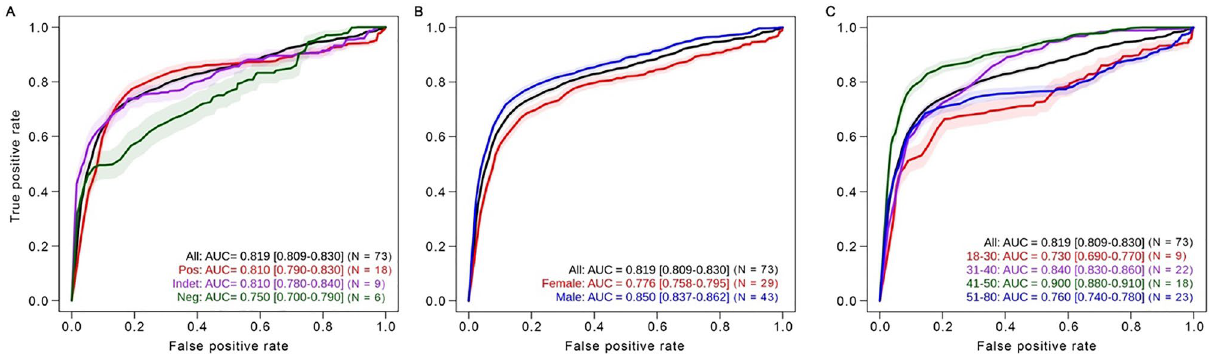
Figure 4. Accuracy changes across different populations. The model trained at PX + 0: PX + 2 showed different performance accuracy (ROC AUC) when we segregated participants by antibody test result ( A ), sex ( B ) and age group ( C ); [95% CI] (N). Each panel uses the participants ( n = 73) who reported positive diagnostic tests for SARS CoV-2 and were included in algorithm training. Pos = positive, Indet = indeterminate, Neg = negative antibody test. The algorithm performed as expected on individuals with positive antibody tests (red), who were very similar to individuals with indeterminate antibody tests (purple). The algorithm was less accurate for individuals with negative antibody tests (green), consistent with the algorithm showing COVID-19 specificity. The ROC AUC for women was lower than the ROC AUC for men. Age groups showed different levels of overall accuracy that were not merely proportional to